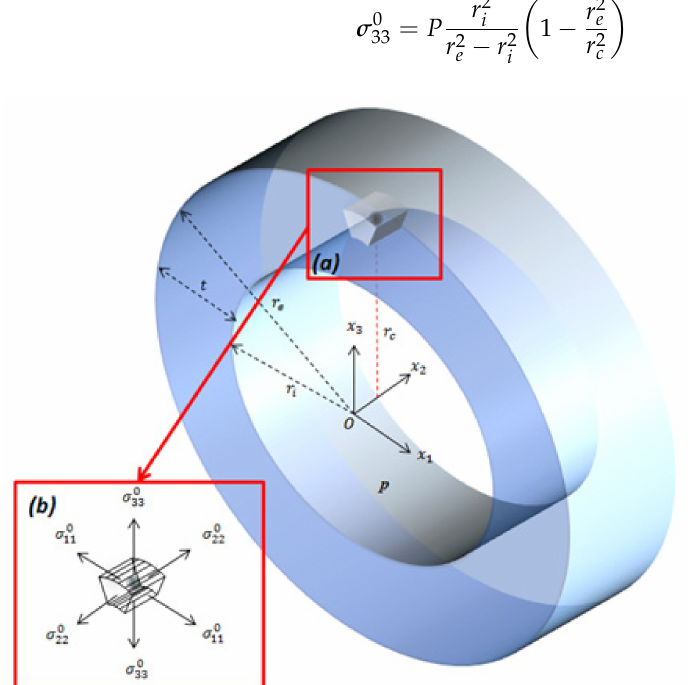
Figure 4. Spherical cavity embedded in the weld of an isotropic-elastic long cylinder: ( a ) elementary solid volume surrounding the porosity and ( b ) components of the average stress acting on the faces of the elementary volume of the solid